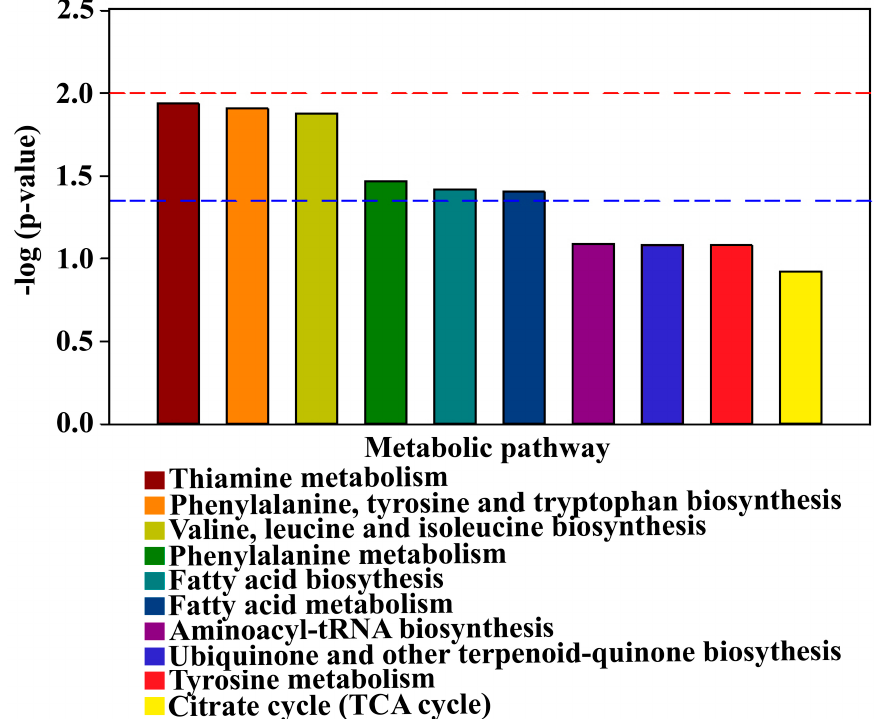
Figure 7. Metabolic pathway enrichment map of different metabolites in healthy (H) and diseased (D) bayberry rhizosphere soil. When the top of the bar is higher than the blue line or red line, the signal pathway it represents is